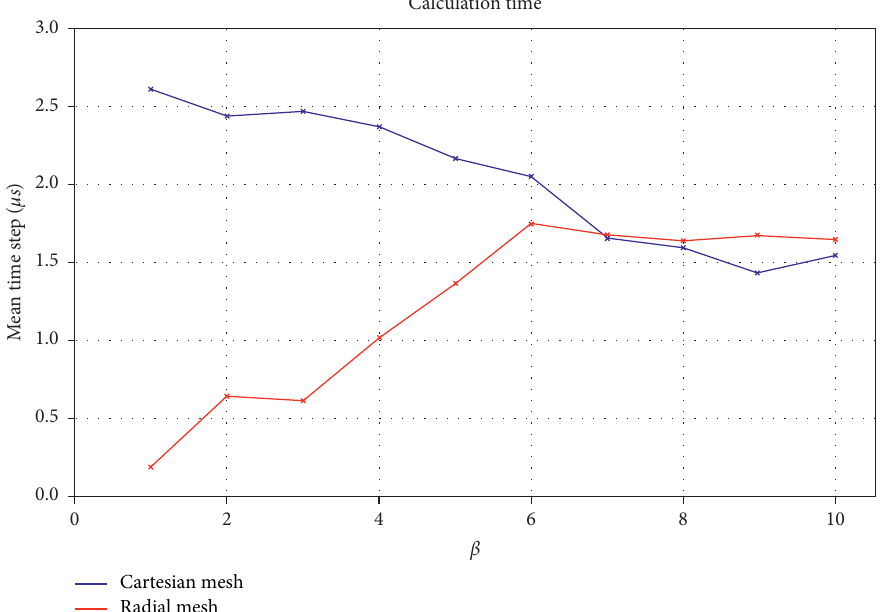
Figure 11: Evolution of the mean time step as a function of the balloon size for Cartesian and radial